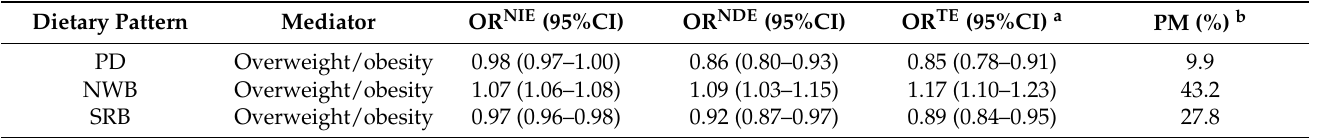
Table 2. Mediation analysis of the associations between dietary patterns and hypertension mediated by overweight/obesity, with CRB as the reference group